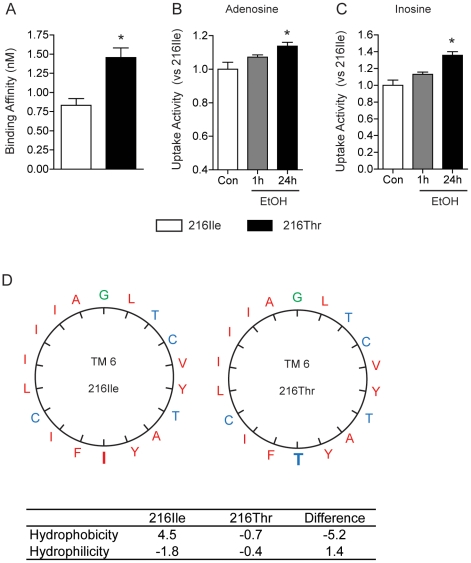
Prolonged Ethanol Exposure Increases Nucleoside Uptake Activity of ENT1-216Thr Compared to ENT1-216Ile.(A) [3H] NBMPR bindings demonstrated reduction of Kd in the ENT1-216Ile and -216Thr in MEF cells. (B–C) Prolonged (24 h) ethanol exposure, but not acute exposure (1 h) to ethanol significantly increased the uptakes of adenosine (B) as well as inosine (C) in ENT1-216Thr compared to ENT1-216Ile (*P<0.05, two-tailed t-test). All data are expressed as mean ± SEM. (D) Increased hydrophilicity in the helical wheel projection of ENT1-216Thr transmembrane domain 6 in the ExPASy (www.ca.expasy.org). The substitution of 216Ile to 216Thr showed decreased hydrophobicity by 5.2 using Kyte-Doolittle scale (4.5 vs. −0.7) and increased hydrophilicity by 1.4 using Hopp-Woods scale (−1.8 vs. −0.4). Green color represents neutral amino acid residues, red and blue color demonstrates hydrophobic and hydrophilic residues, respectively.